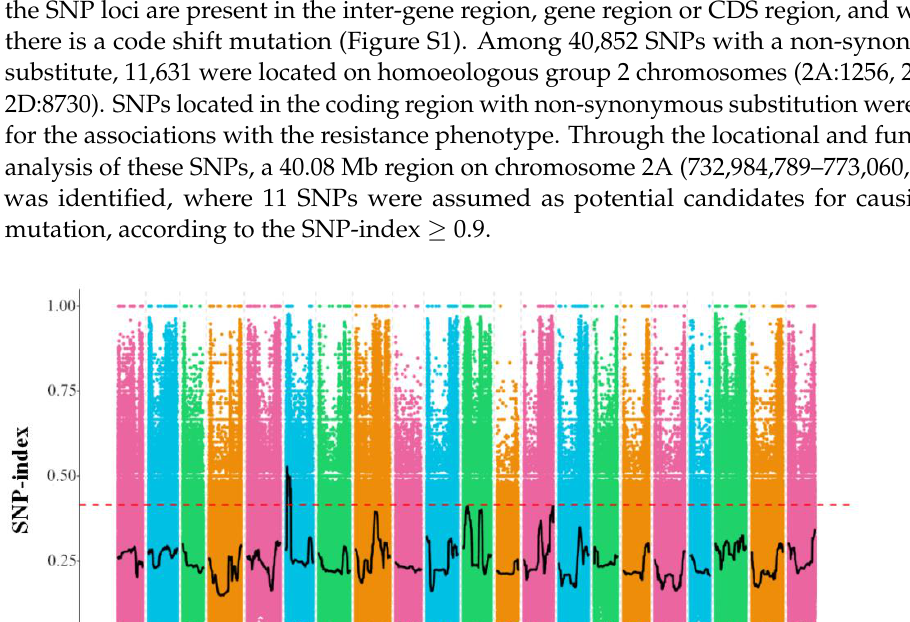
Figure 1. Number of polymorphic SNPs distributing on different chromosomes associated with stripe-rust resistance, based on RNA-Seq of resistant and susceptible bulks.